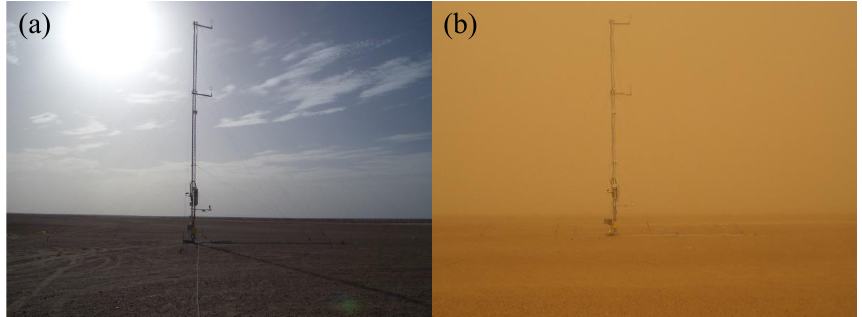
Figure 2. Tower at SS1 in Bordj Badji Mokhtar in Algeria with the LACO–UMBC instruments during an episode of low (a) and high (b) concentration of dust aerosol taken on 8 and 17 June, respectively. The inverse integrating nephelometer, optical reflectometer, and the LACO aerosol sampling station were installed with inlets 3m above the ground level. Image credit: Mohammed Salah and Bouzine Ouchene, ONM, Algeria.